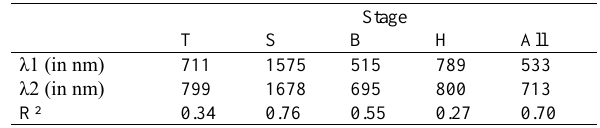
Table 4. Coefficient of determination (R²) for the relationship